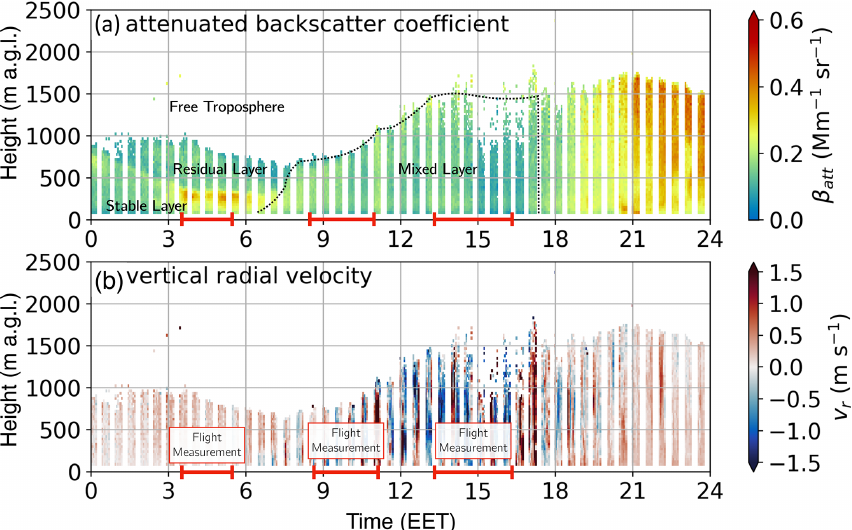
Figure 9. Doppler lidar measurement at Hyytiälä, SMEAR II station, from 16 May 2017. (a) Attenuated backscatter coefficient and (b) ver- tical radial velocity measured on 16 May 2017 at SMEAR II station. The measurements were used to estimate the height and vertical extent of the different layers of the boundary layer, such as stable (boundary) layer, residual layer, mixed layer, and free troposphere. The red line on the time axis indicates the airborne measurement periods. The vertical radial velocity (b) shows the vertical mixing and the resulting increase in the boundary layer